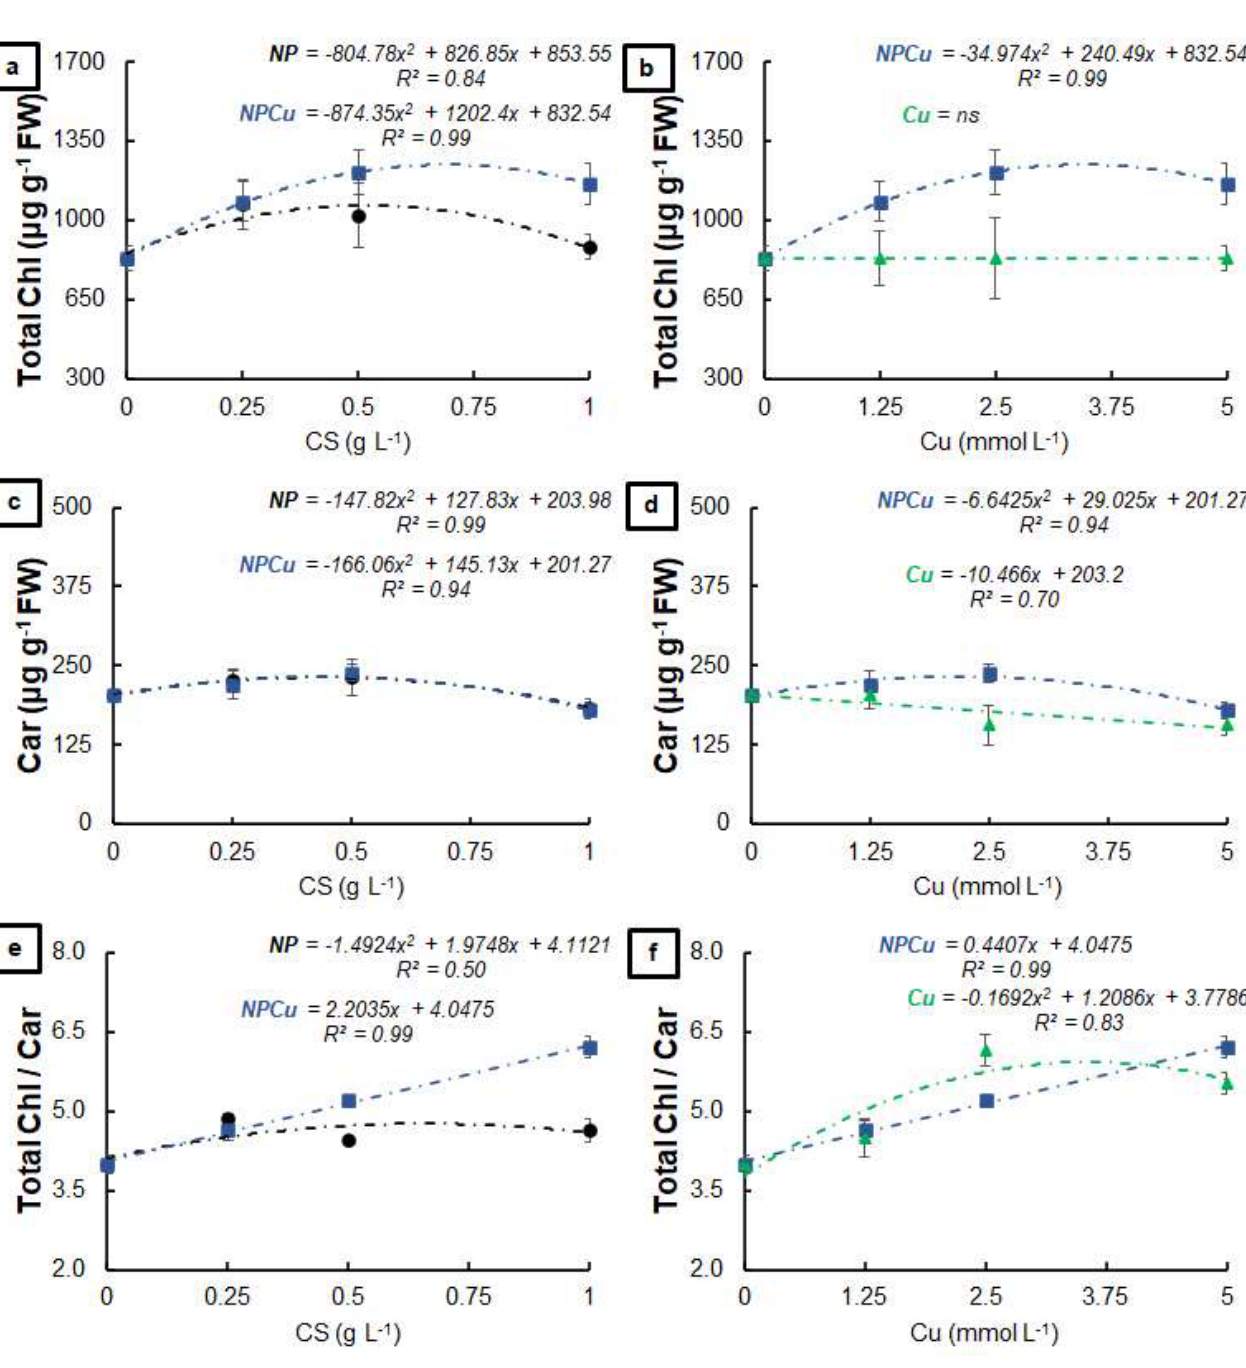
Figure 2. Total chlorophyll ( a , b ), carotenoids ( c , d ), and total chlorophyll/carotenoids ratio ( e , f ) of leaf discs of Coffea arabica cv. IPR 100 at 40 days after treatment with distilled water, as a control (CONT), chitosan nanoparticles without Cu 2+ ions (NP), chitosan nanoparticles containing Cu 2+ ions (NPCu), and free Cu 2+ ions (Cu). The formulations were diluted in distilled water, obtaining the corresponding concentrations of chitosan (CS) in NP and NPCu treatments (0.25; 0.5; 1 g L −1 ) and of Cu 2+ ions (1.25; 2.5; 5 mmol L −1 ) in NPCu and Cu treatments. Results are expressed as mean ( n = 4) ± standard error. The model and coefficient of determination (R 2 ) are also shown ( p < 0.05). ns = not significant.